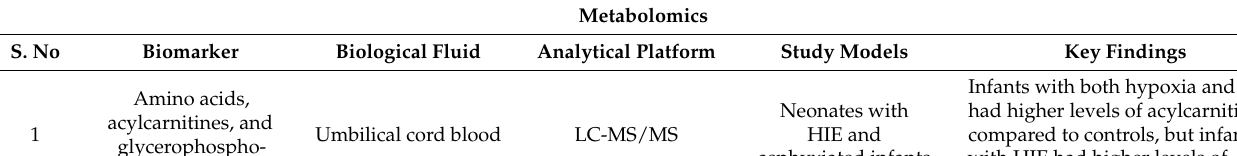
Table 3. Various metabolomics markers in